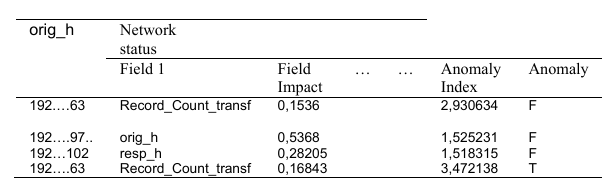
Table 1. Example of the dataset used in the